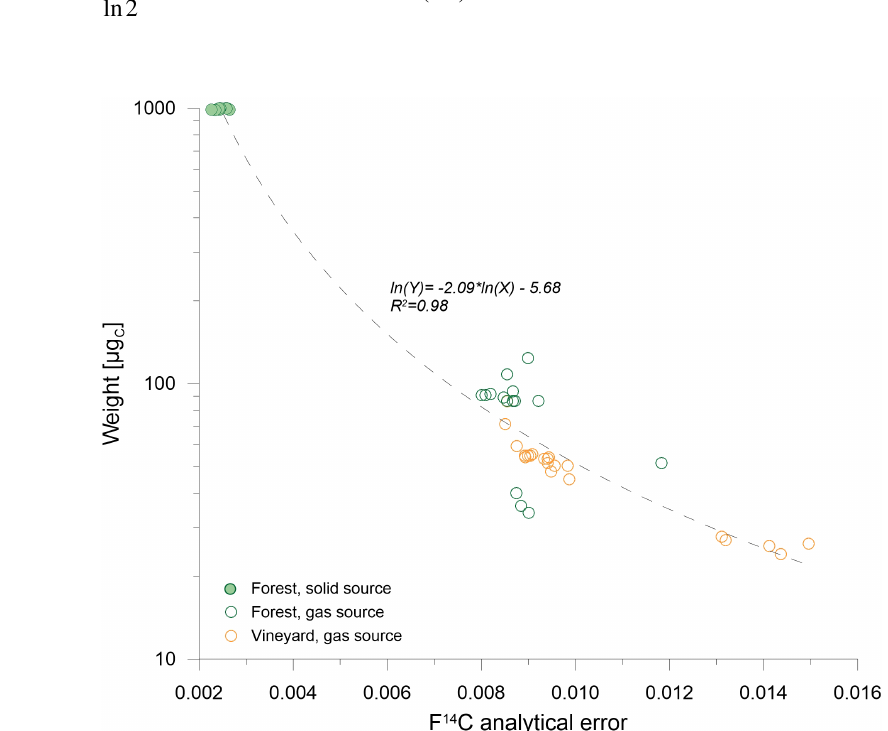
Figure C1. Influence of the carbon mass of the measured sample on the analytical error of ECHoMICADAS. The solid green circles represent soil samples obtained under the forest analyzed with the solid source, the empty green circles those analyzed with the gas source, and the empty orange circles are the soil samples obtained under vines analyzed with the gas